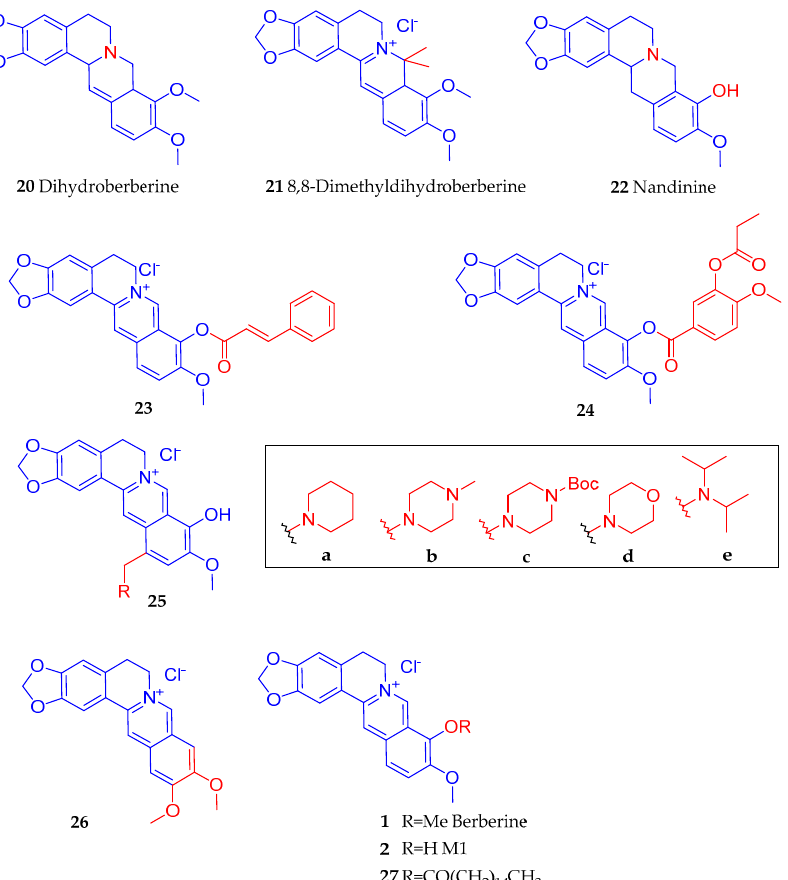
Figure 5. Further examples of berberine derivatives with antidiabetic promise.